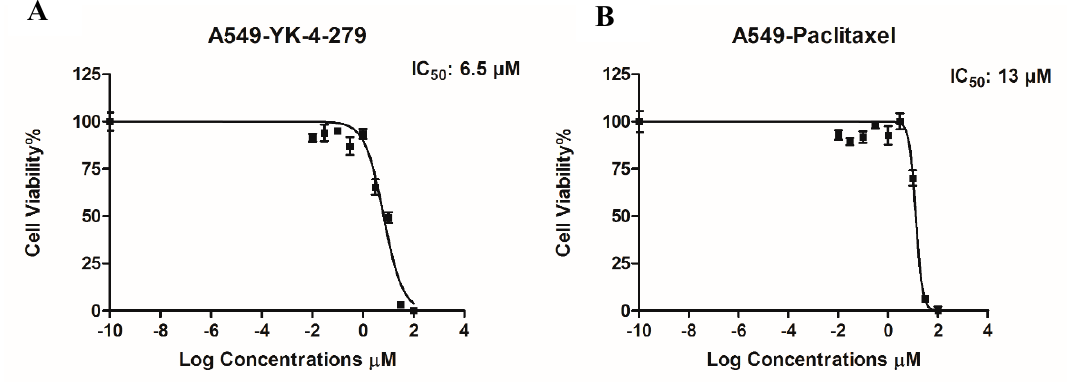
Figure 1. ( A ) IC 50 graph of A549 cell line treated with YK-4-279. ( B ) IC 50 graph of A549 cell line treated with Paclitaxel.